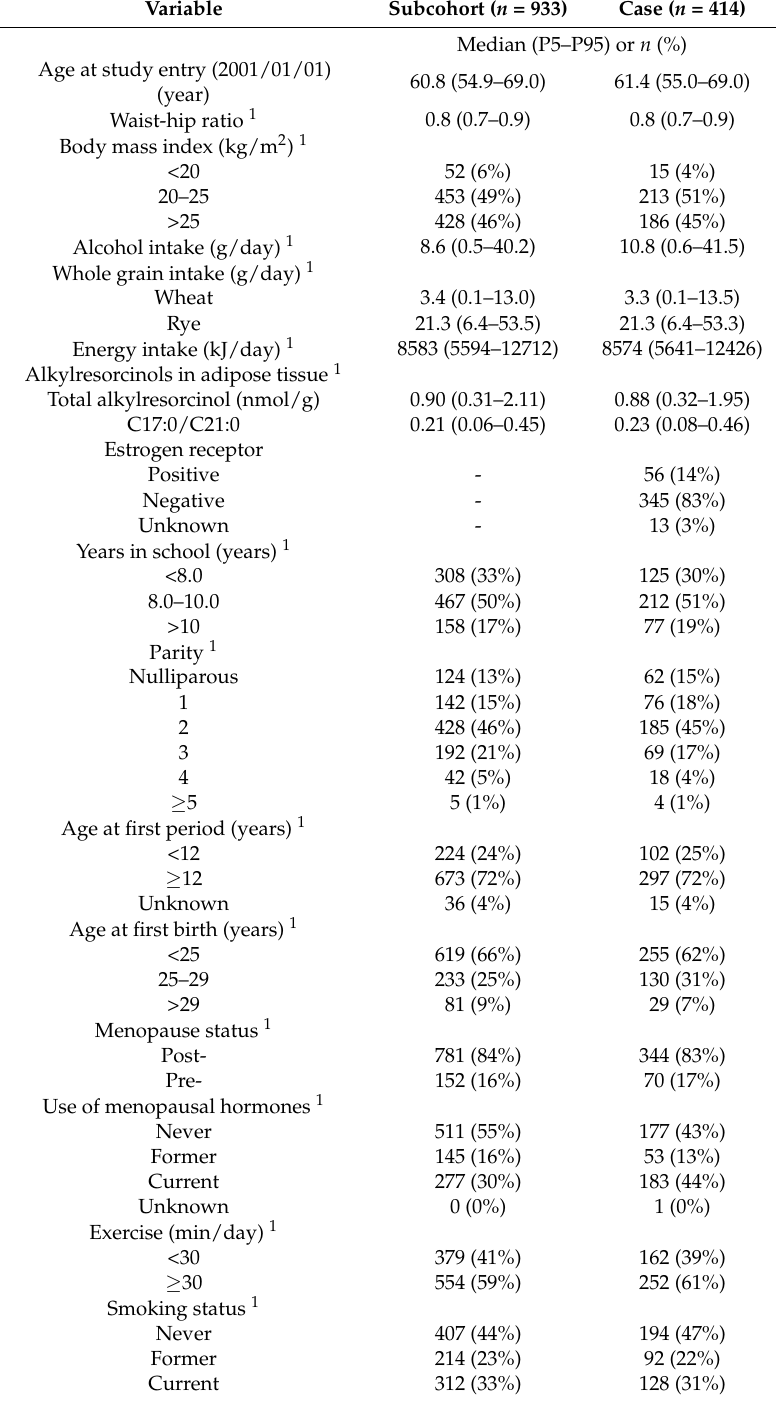
Table 1. Characteristics at baseline of women in the case and subcohort groups in a case-cohort study on the Danish Diet, Cancer and Health